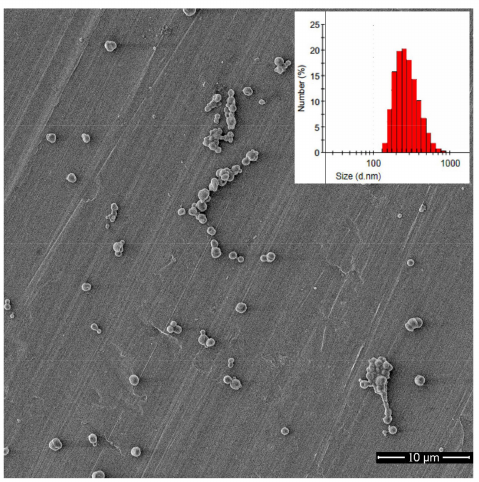
Figure 8. Scanning electron microscope (SEM) image of the self-assembled aggregates for m PEG 43 - b -P[(TMC-C) 20 TMC 20 ] in pH = 7.